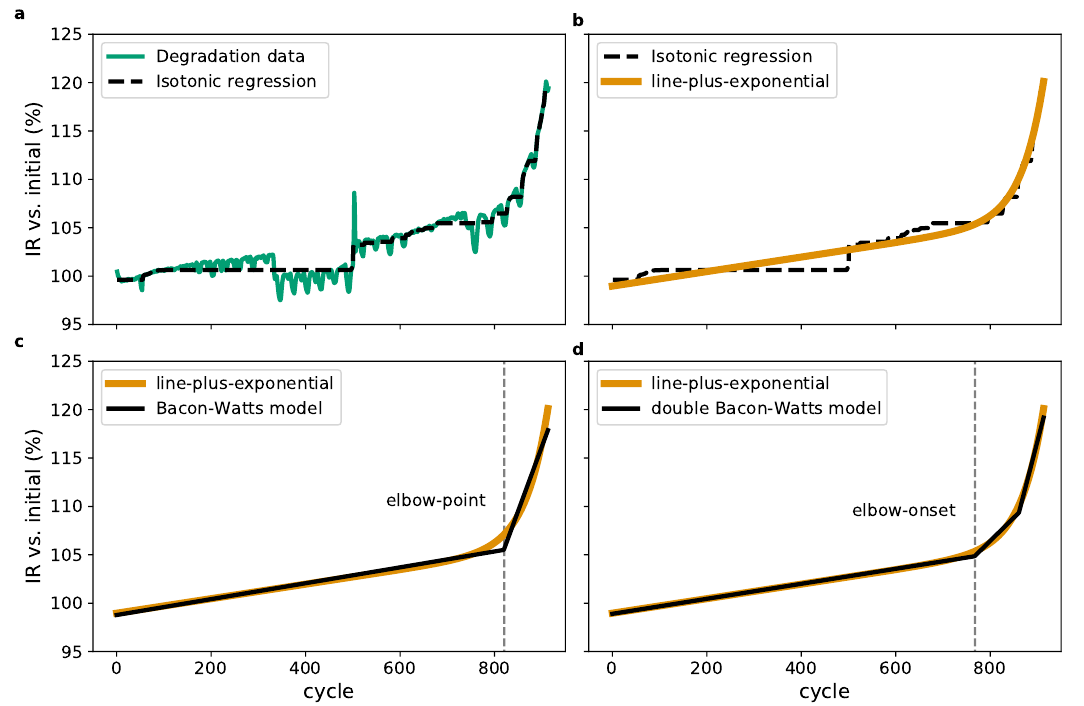
Figure 4. Steps of Algorithm 1 applied to the internal resistance degradation curve of cell b1c29 (non-predicted data). ( a ), step 1. ( b ), step 3. ( c ), step 4. ( d ), step 5. Step 2 is omitted as it has no impact here: n ∗ is chosen as the final cycle number. The width of the 95% confidence interval (computed by the non-parametric bootstrapping procedure) for the elbow-point of this curve is 23 cycles, and for the elbow-onset it is 38 cycles.